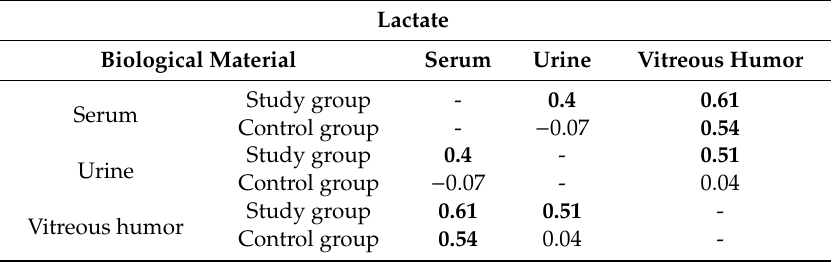
Table 11. Correlation between lactate concentration in di ff erent biological materials. Significant correlations are in